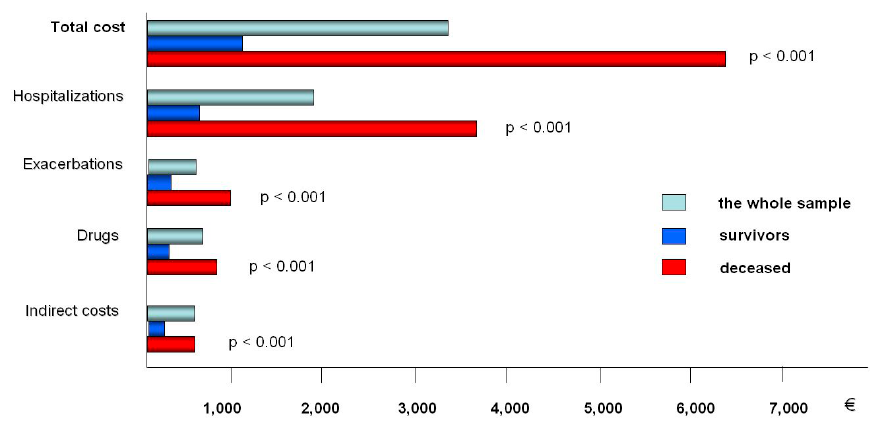
Figure 2. The mean total annual cost per patient and the corresponding components of cost (due to hospitalizations, nonadmitted exacerbations, pharmacological treatment, and indirect costs) in the whole sample, in survivors at three years and in those patients who died during the three years of survey.